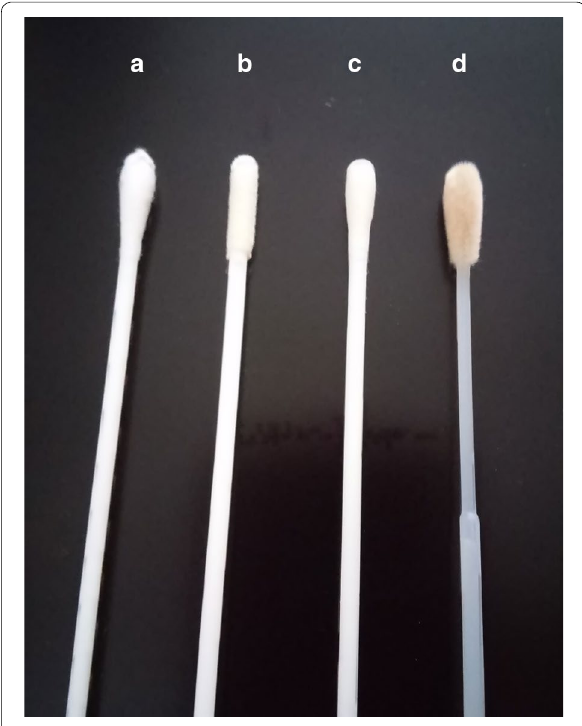
Fig. 1 Swab types used in the study: A—dacron swab, B— polyurethane foam, C—rayon swab, D—flocked nylon